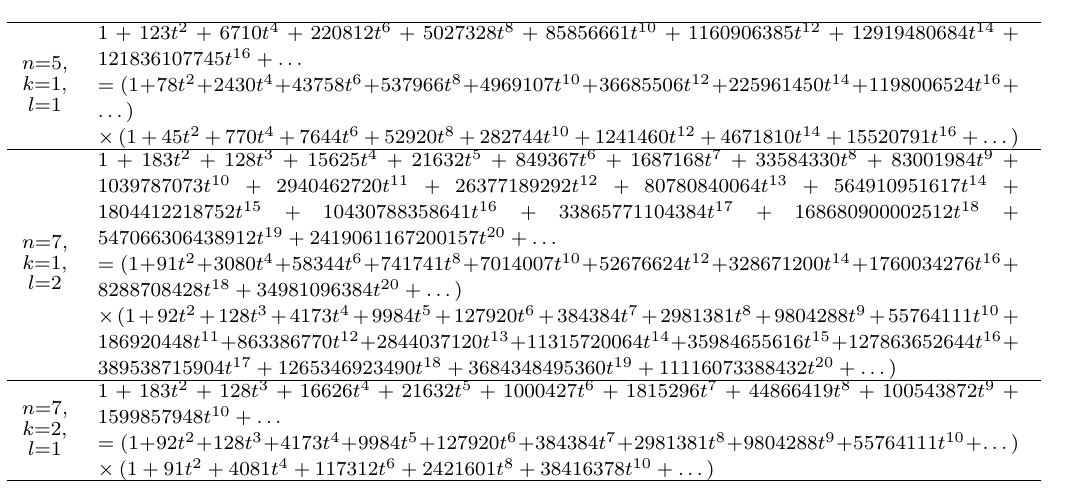
Table 10. Hilbert series results for (2.14). The first line displays the Coulomb branch Hilbert series for (2.14), while the second line displays the factorisation into a product. Each factor is consistent with the known Hilbert series for the individual theories in (2.15).